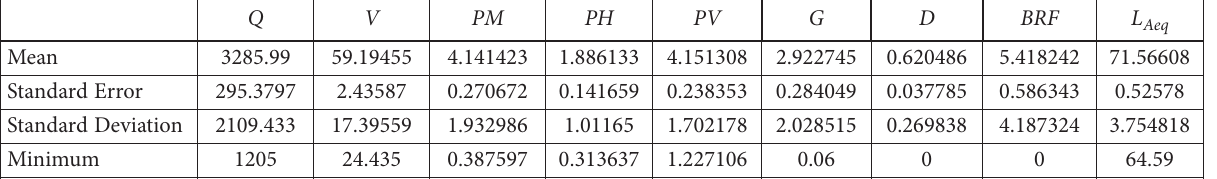
Table 3. Descriptive statistics of variables